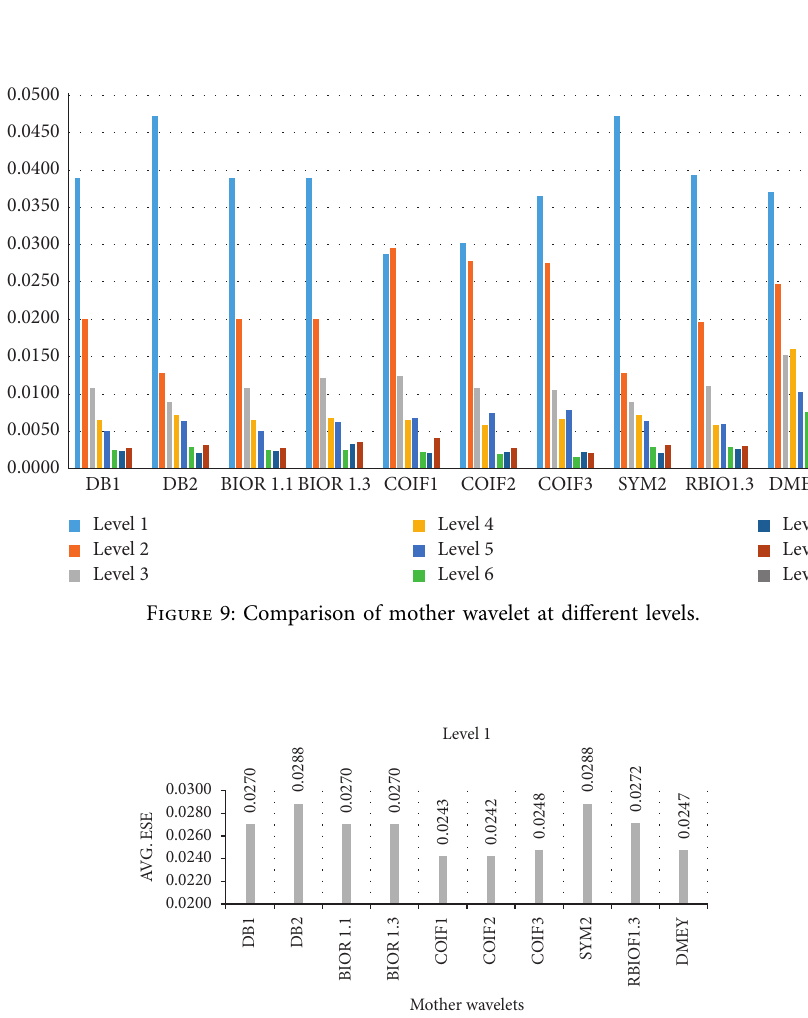
Figure 10: Comparison of DB mother wavelet at different